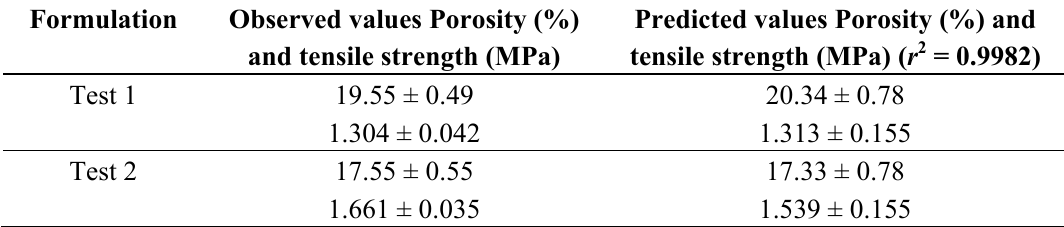
Table 2. Observed versus MLP predicted values for test formulations.